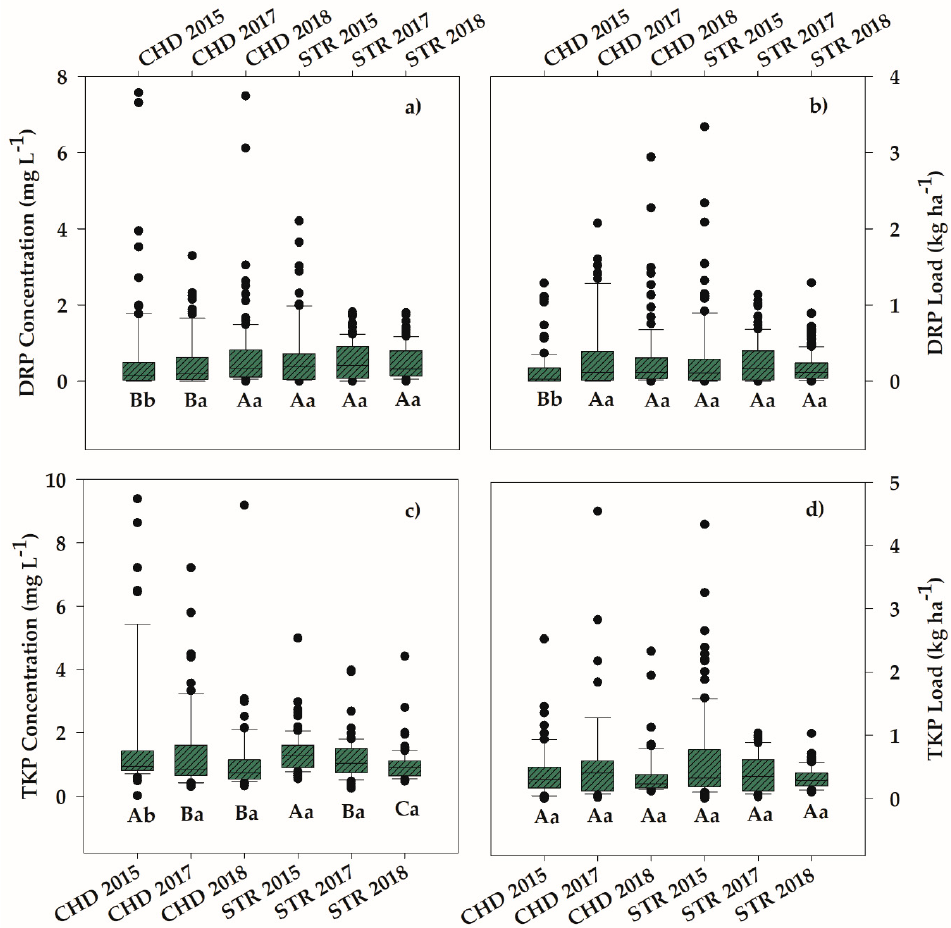
Figure 4. Comparison of dissolved reactive phosphorus (DRP). ( a ) DRP concentrations (mg L − 1 ), ( b ) DRP loads (kg ha − 1 ), ( c ) total Kjeldahl phosphorus (TKP) concentrations (mg L − 1 ), and ( d ) TKP loads